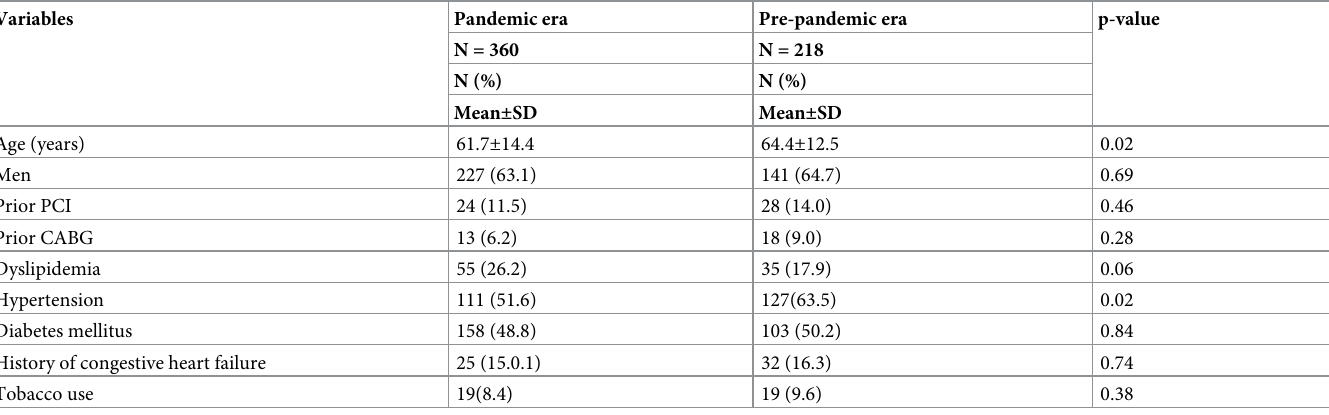
� Data of 157 patients missing; chi-square test for categorical and student’s t-test for continuous variables is used;p-value < 0.05 is significant; NS (non-significant) = p- value > 0.05.